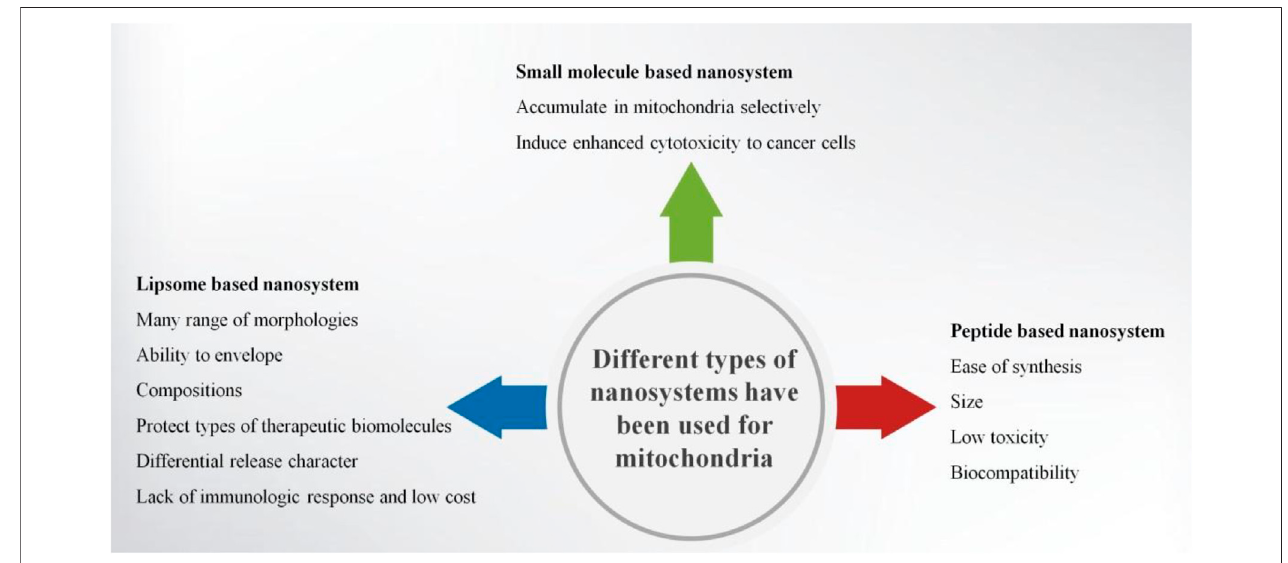
FIGURE 3 | Diagram of the different types of nanosystems for targeting